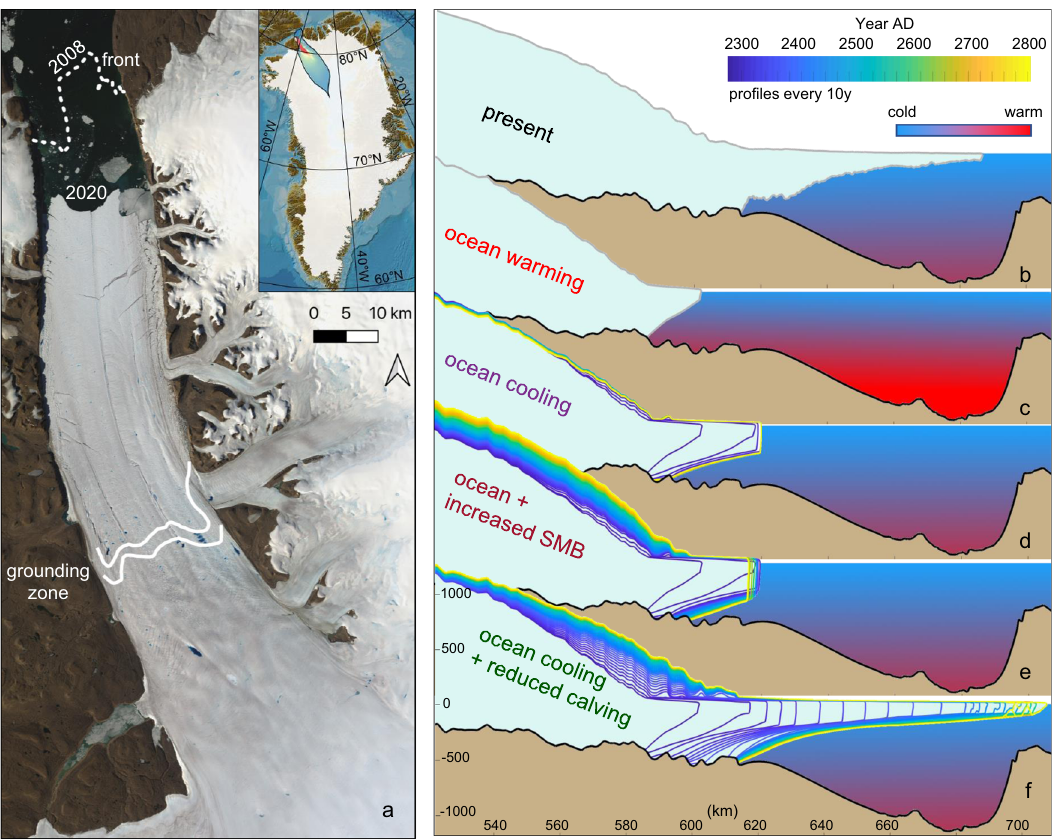
Fig. 1 An ocean cooling and reduced calving permit Petermann ’ s ice shelf to recover once it has disappeared. a Present-day Petermann Glacier, b contemporary pro fi le view, c geometry by 2300 AD after a 2 °C ocean warming. Glacier evolution in response to an attempted recovery is shown for d an ocean cooling, e an ocean cooling and an increased surface mass balance (SMB) and f an ocean cooling and reduced calving rates. The present-day grounding zone and calving front is shown in a . The satellite image is from Landsat-8, taken July 24, 2020, courtesy of the U.S. Geological